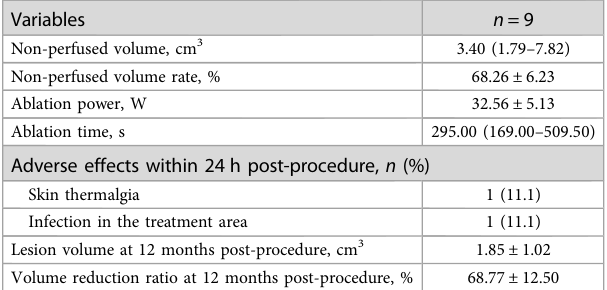
TABLE 4 Perioperative and postoperative evaluation of ablation for